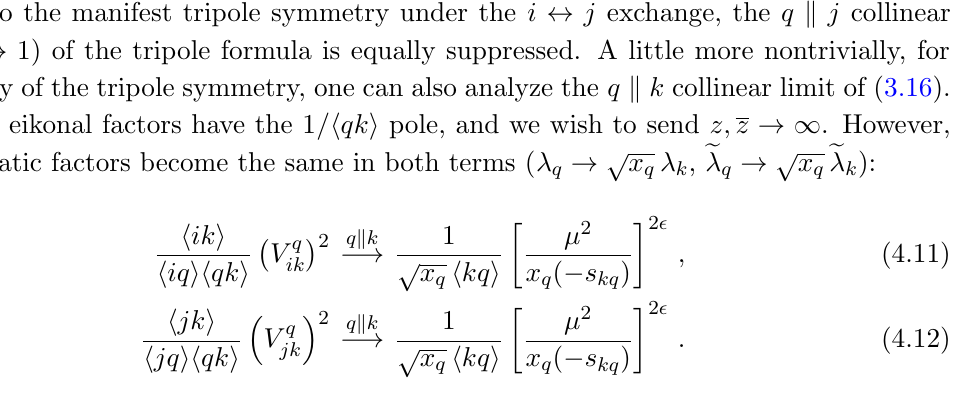
so that we need to analyze the limit of the transcendental functions D